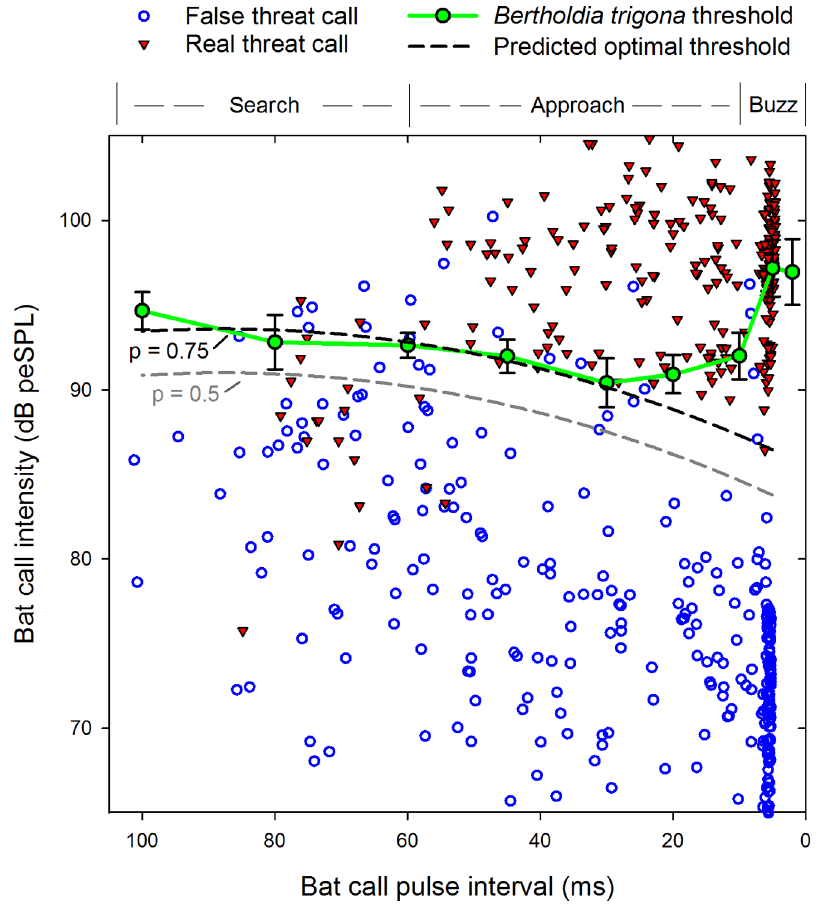
Figure 4. Predicted and measured clicking thresholds for different bat echolocation pulse-intervals in Bertholdiatrigona . Echolocation call intensity and pulse interval impinging upon a tethered focal moth are shown for five attacks on individual noctuid moths (real threat) and nine attacks on nearby, free-flying moths (false threat; see figure 2). The optimal threshold for discriminating real and false threats was determined using quadratic discriminant analysis with 50% (p=0.5) and 75% (p=0.75) likelihood of a call being assigned as a real threat. Bertholdia trigona clicking thresholds (mean 6 s. e.) measured from eight moths suspended in a sound chamber matched predicted p=0.75 thresholds for pulse intervals of 35–100 ms.